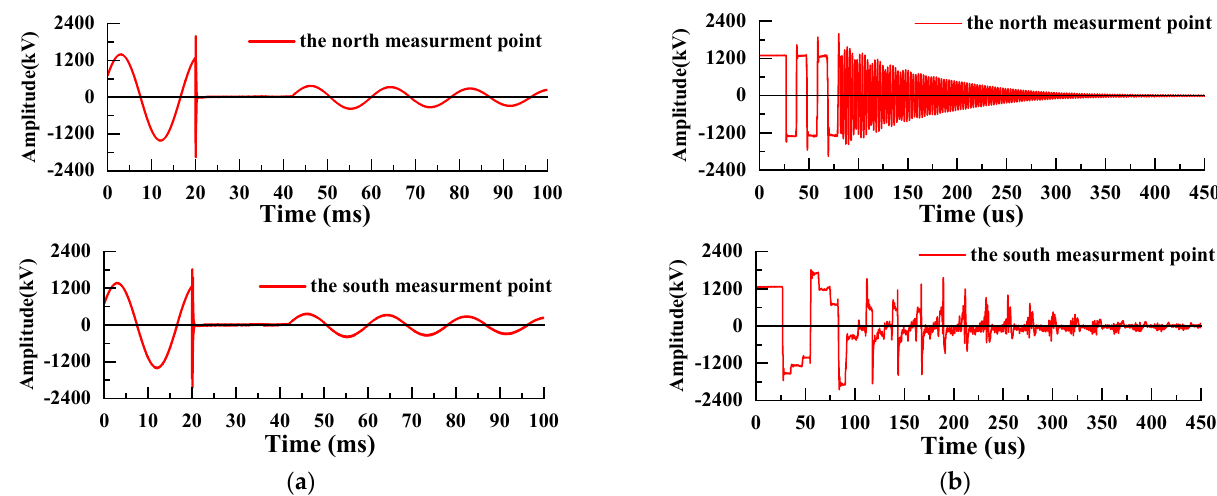
Figure 6. Transient voltage waveform generated by the SF 6 gap breakdown in 1100 kV GIL during dielectric withstand voltage test. ( a ) Full recorded waveform within 100 ms; ( b ) an expanded view of the transient waveform.